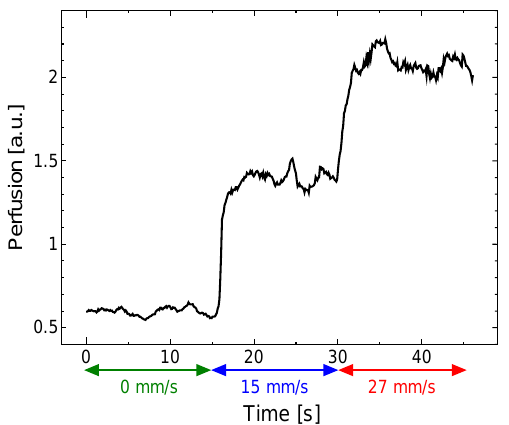
Figure 10. Time-dependent perfusion signals calculated from perfusion spectra during the entire measurement. Perfusion signal increased rapidly when flow velocity increased.